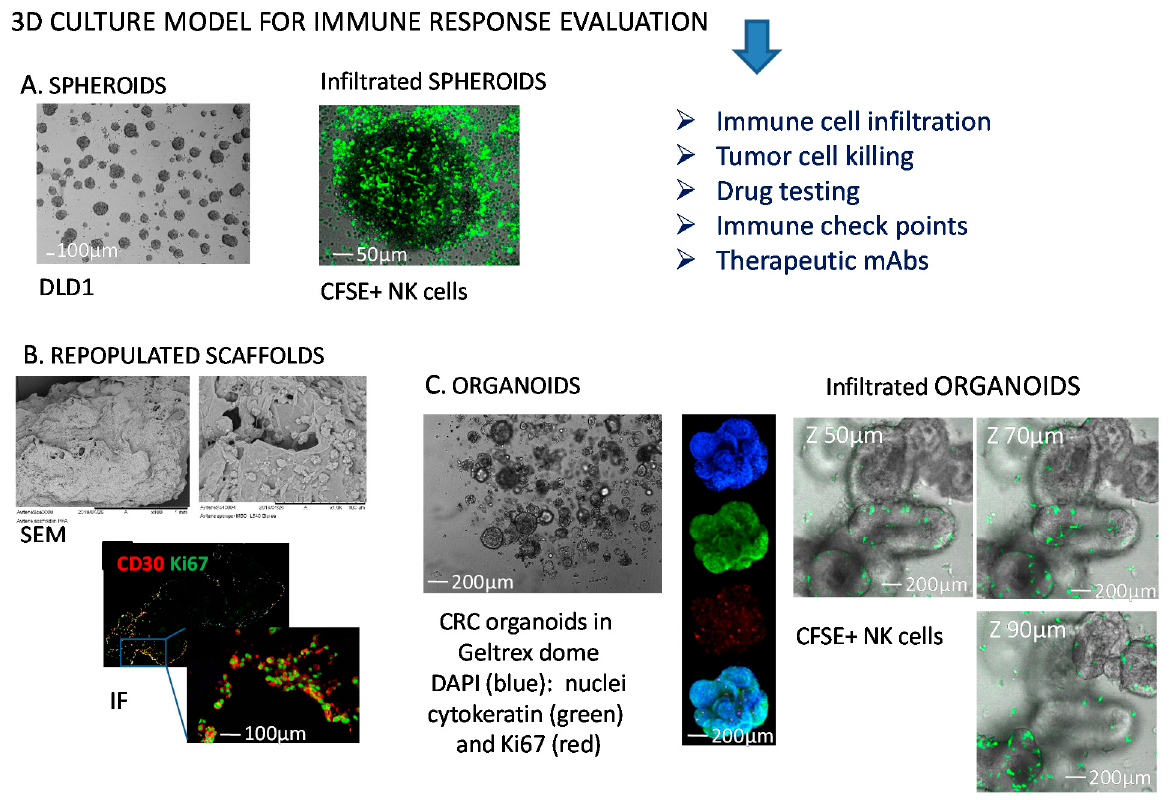
Figure 1. Representative 3D models to study NK-tumor cell interactions. ( A ) Colorectal cancer (CRC) cell spheroids from DLD1 CRC cell line (left) infiltrated with NK cells (right) labelled with the green fluorescence probe carboxy fluorescein succinimidyl ester (CFSE). ( B ) Collagen scaffolds repopulated with mesenchymal stromal cells and Hodgkin’s lymphoma cells (scanning electron microscopy, SEM, upper) or analyzed by immunofluorescence (IF, lower) for the expression of CD30 antigen (HL cells, red) and Ki67 (proliferating antigen, green); ( C ) CRC organoids in a Geltrex TM dome (left), or labelled (middle) with 4 ′ ,6-diamidino-2-phenylindole (DAPI, blue), cytokeratin 2 (green), Ki67 (red), or merge (lower image); organoids analyzed by confocal microscopy upon NK cell (green labeled with CFSE) infiltration at different Z-stages (right). The dimension bars are shown in each panel.